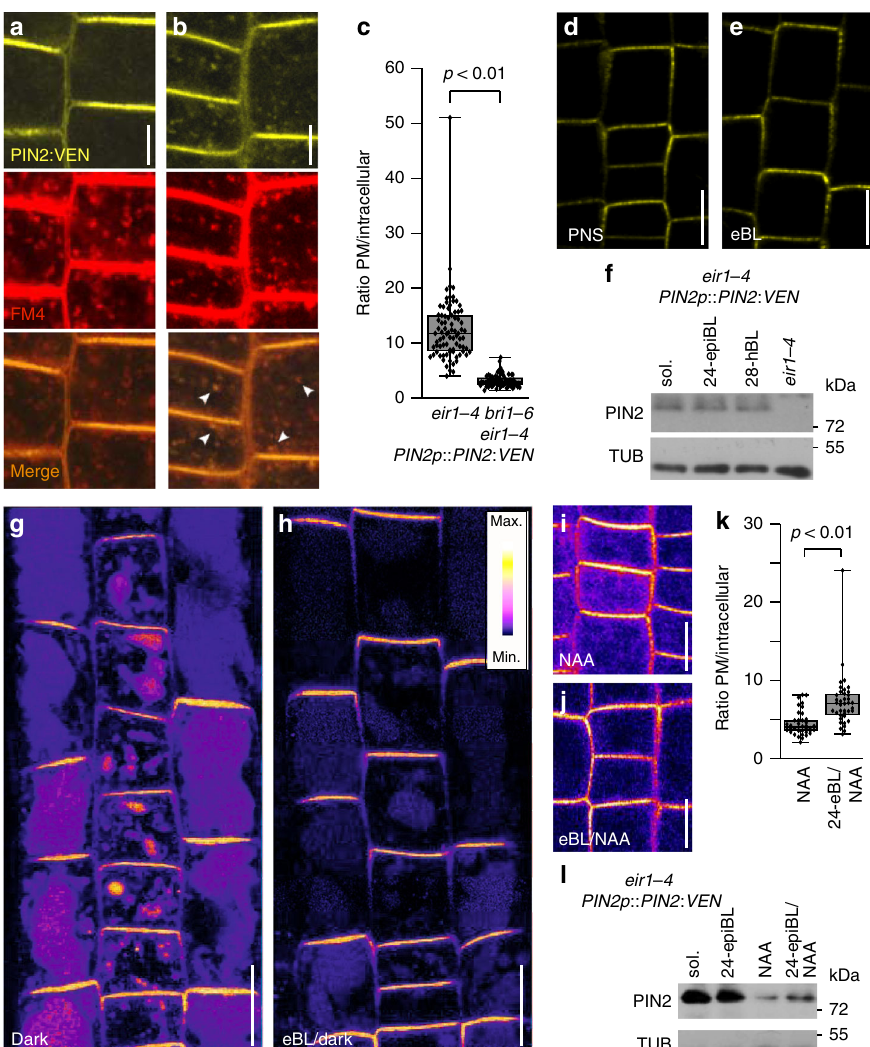
Fig. 4 Sorting of tagged wild type PIN2 is modulated by brassinolide. a , b Top panels: PIN2:VEN distribution in 6 DAG day-old eir1-4 PIN2p::PIN2:VEN ( a ) and bri1-6 eir1-4 PIN2p::PIN2:VEN ( b ) root meristem epidermis cells. Middle panels FM4-64 distribution after 20 min of treatment (FM4). Bottom panels: Merged images. White arrowheads: co-localization in endocytic vesicles. c PIN2:VEN signal ratio between PM and endosomal vesicles in eir1-4 PIN2p::PIN2: VEN and bri1-6 eir1-4 PIN2p::PIN2:VEN root meristem epidermis cells ( n = 8 roots and 82/72 cells/dataset). Two-tailed t -test analysis of resulting values revealed a signi fi cant difference. d, e PIN2:VEN in 6 DAG eir1-4 PIN2p::PIN2:VEN root epidermis cells in mock-treated samples PNS ( d ) or with 100 nM eBL for 16 h ( e ). f Western blots performed with eir1-4 PIN2p::PIN2:VEN root membrane protein fraction grown on PNS or treated with 100 nM eBL or 28- homoBL for 16 h. Membrane protein extract from eir1-4 served as control. g, h Heat map of eir1-4 PIN2p::PIN2:mCherry root meristem epidermis cells at 6 DAG, seedlings were grown with roots in the dark, either on control medium ( g ) or treated with 100 nM eBL for 3 h ( h ). i, j Heat map of PIN2:VEN distribution in epidermis cells of 6 DAG eir1-4 PIN2p::PIN2:VEN , treated with 10 μ M NAA for fi ve hours ( i ) or pre-treated with 100 nM for 16 h before NAA treatment ( j ). k Box plot, displaying PIN2:VEN signal distribution after NAA and eBL/NAA treatments (see ‘ i , j ’ ; n = 5 roots and 39 cells/dataset). l Western blots performed with eir1-4 PIN2p::PIN2:VEN root membrane protein fraction treated with 10 μ M NAA for 5 h (NAA) or pre-treated with 100 nM eBL for 16 h before NAA treatment (24-epiBL/NAA). Material from mock-treated (sol.) and eBL-treated seedlings (24-epiBL), served as controls. Anti- α - tubulin (TUB) was used as loading control. Whiskers in box plots represent the entire range of outliers; gray boxes: fi rst and third quartiles; center line: median; dots: values obtained. Two-tailed t -test analysis has been performed to test for p-values. Scale bars: a, b = 5 μ m; d, e, g – j = 10 μ m. Source data are provided as Source Data fi